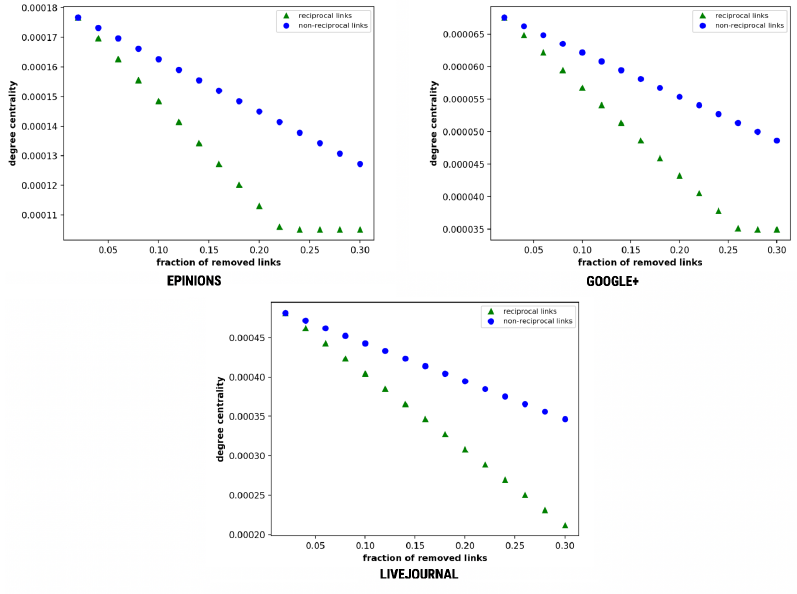
Figure 11. Affected degree centrality as a function of the fraction of removed